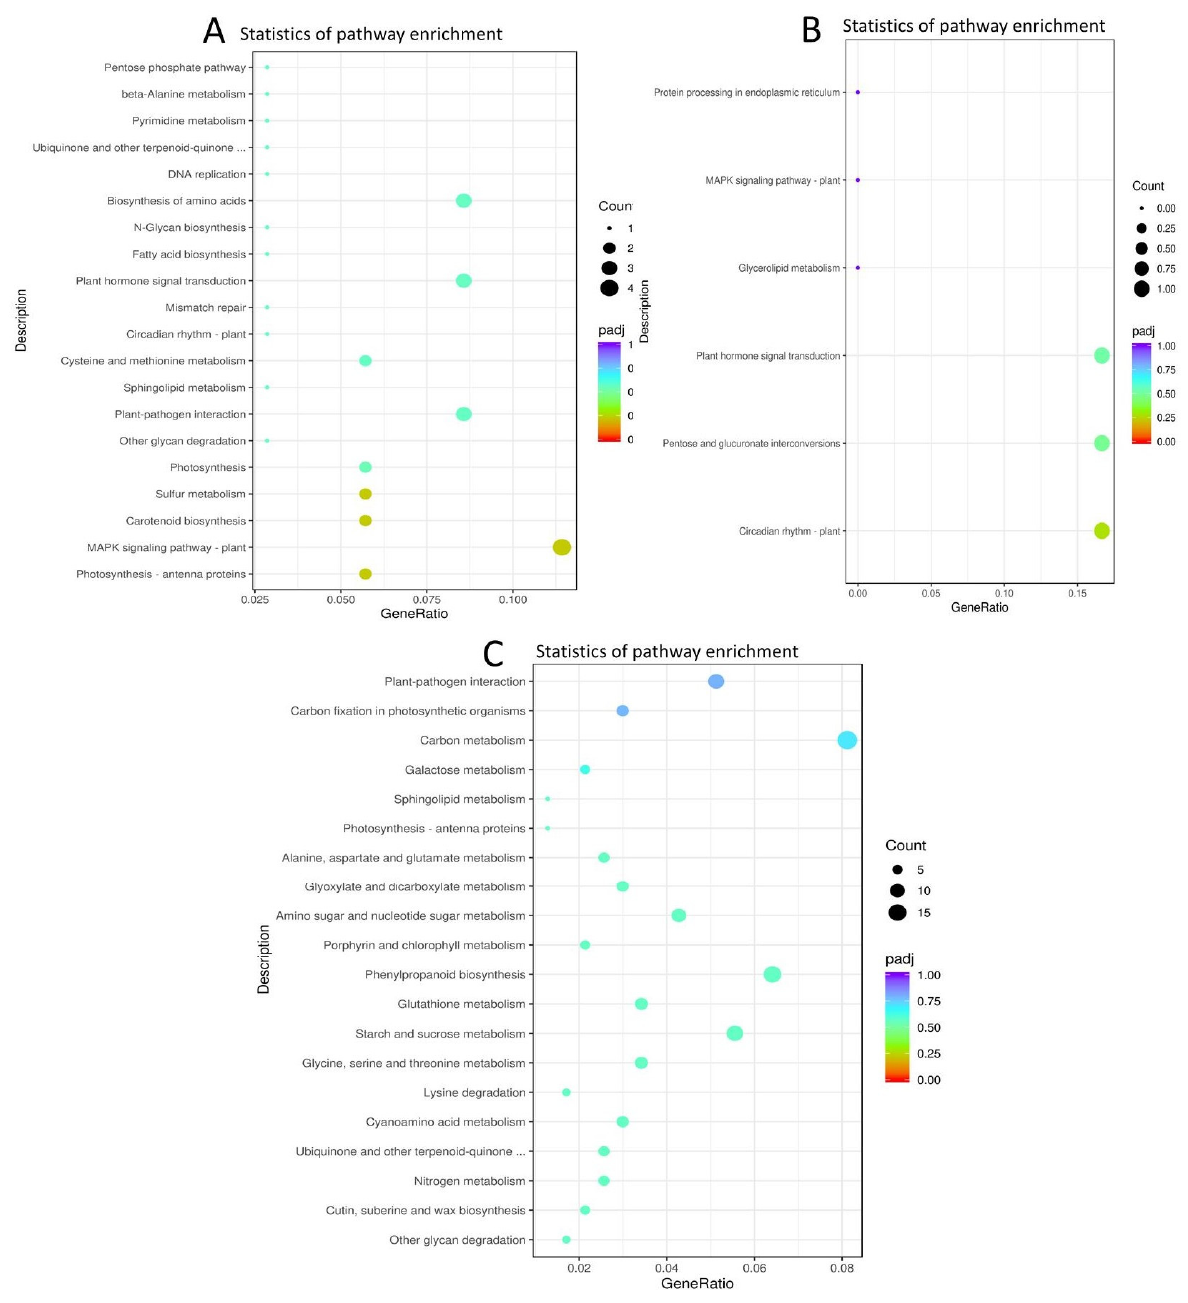
Figure 4. Significantly enriched KEGG pathways of DEGs in timepoint pairwise comparisons. ( A